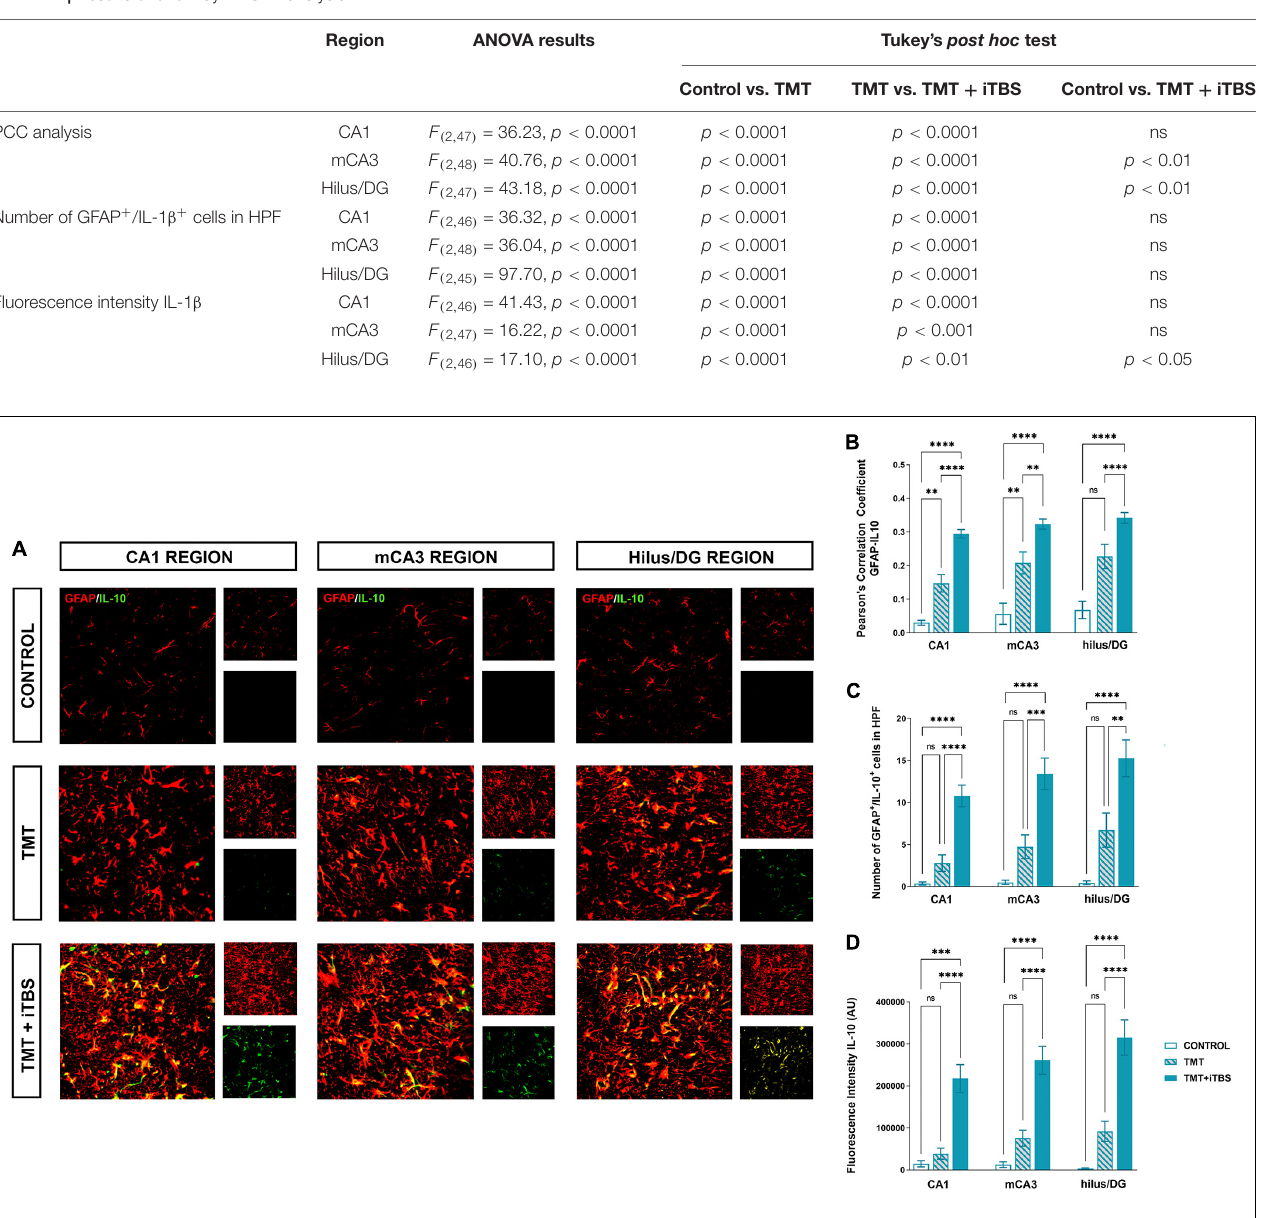
FIGURE 5 | Effect of iTBS treatment on the inflammatory status of reactive astrocytes. (A) Immunofluorescence staining directed to GFAP ( red ) and IL-10 ( green ) of coronal hippocampal sections captured in the same region levels and. Scale bar = 50 µ m. Integration of immunofluorescence intensity and quantitative analyses showing (B) Pearson’s correlation coefficient (PCC), (C) number of GFAP + /IL-10 + cells in high power field (HPF), and (D) fluorescence intensity of IL-10 in arbitrary units (AU). Bars represent the mean values ± SEM of specific parameters calculated from all acquired images (10–16/animal). Results of post hoc Tukey’s test